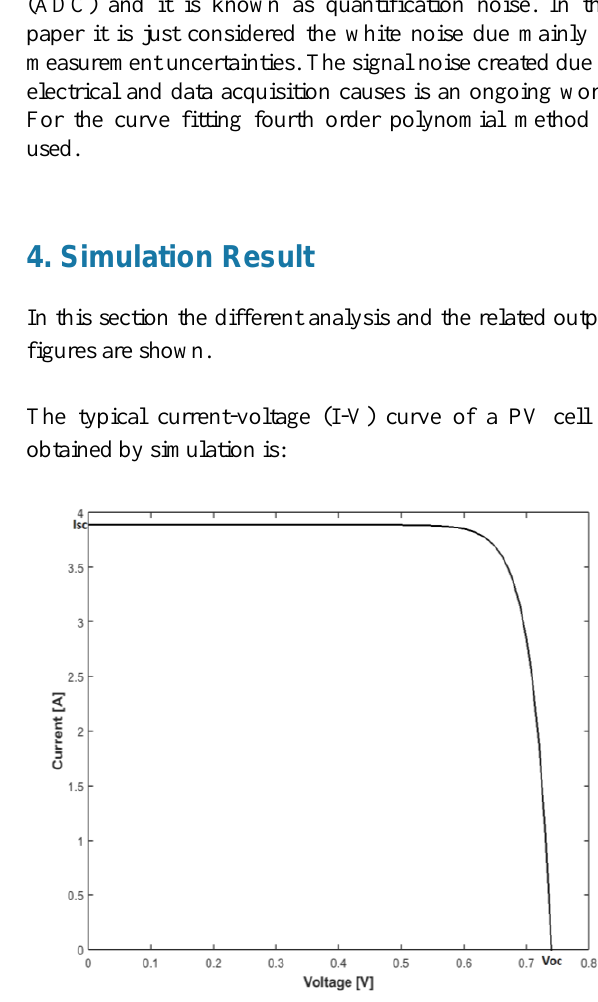
Figure 1. PV cell equivalent circuit.